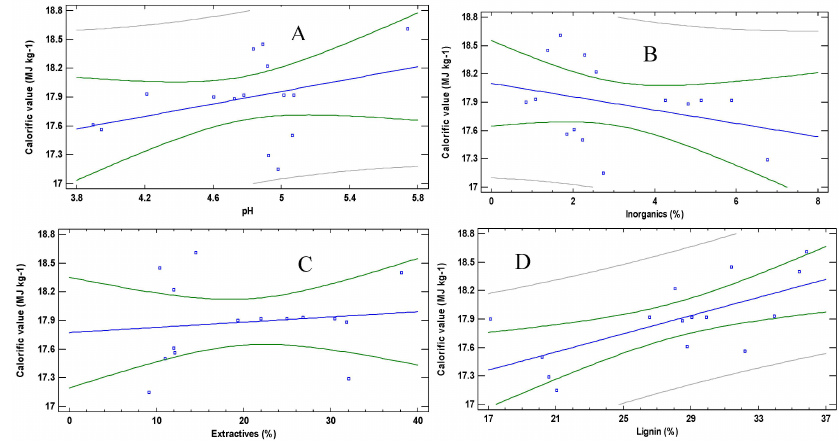
Figure 4. Linear regressions and error bounds at 95% confidence interval of the calorific value in function of chemical constituents ( A : pH, B : Inorganics, C : extractives and D : lignin) of five timber species of the Mexican semi-arid